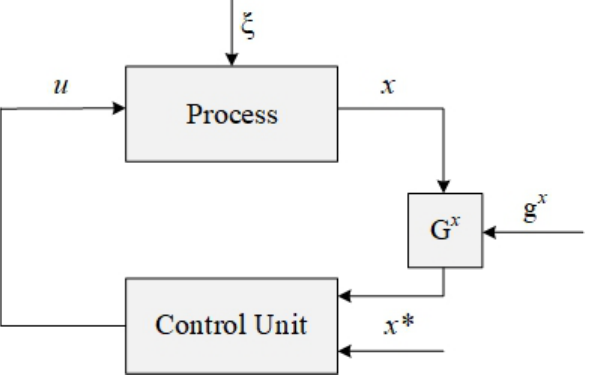
Figure 1. The general scheme of closed loop